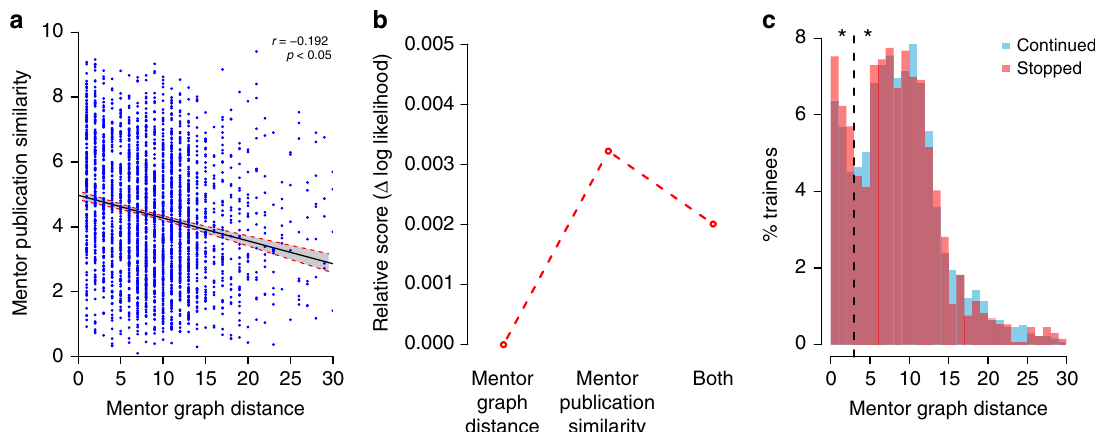
Fig. 6 Relationship between the mentor early similarity in publications and their common ancestor distance, and their respective predictive power in the model. a Scatter plot with linear regression, the shaded area displays the 95% con fi dence interval in prediction. b Relative contribution to the model goodness-of- fi t, when acting in isolation or together. c Distribution of common ancestor distance for the trainees who stopped (red) or continued (blue) an academic research career. The dashed line indicates the boundary between the two peaks in the distribution of mentor graph distance. Probability of continuing is signi fi cantly smaller for the group with shorter graph